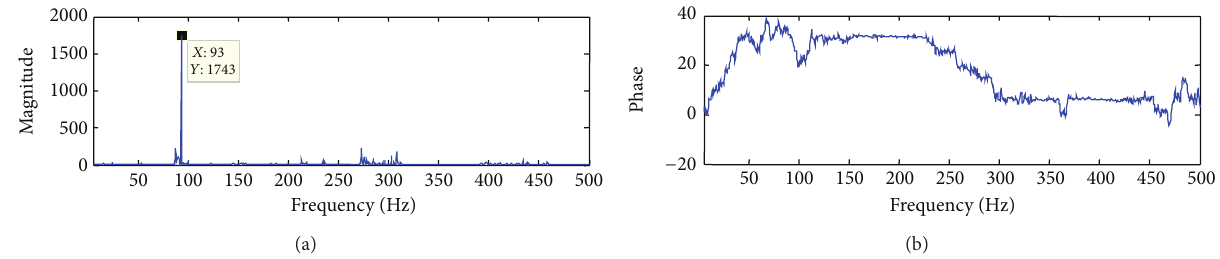
Figure 10: Fictitious frequency response function in the case of a fault on the outer race of the ball bearing (sensor at 𝑆 1 is moved to the point 𝐴 in Figure 4): (a) magnitude spectrum and (b) phase